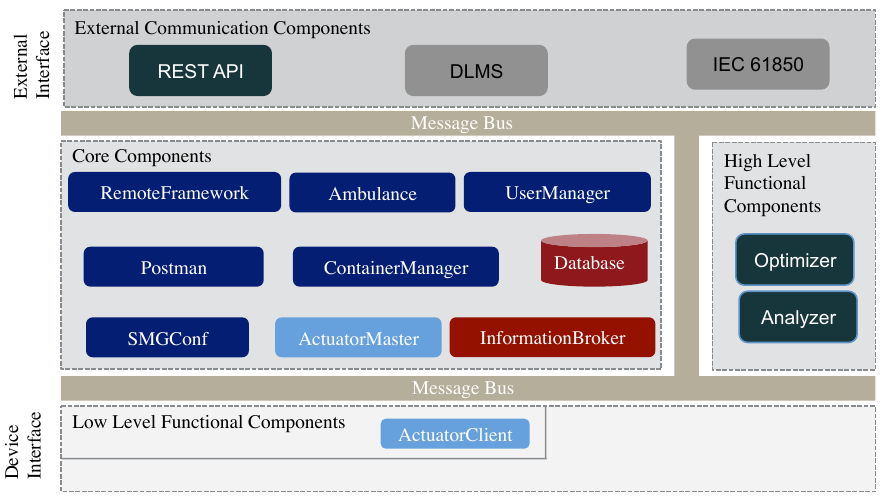
Figure 3. Component-based architecture of the Microgrid Controller